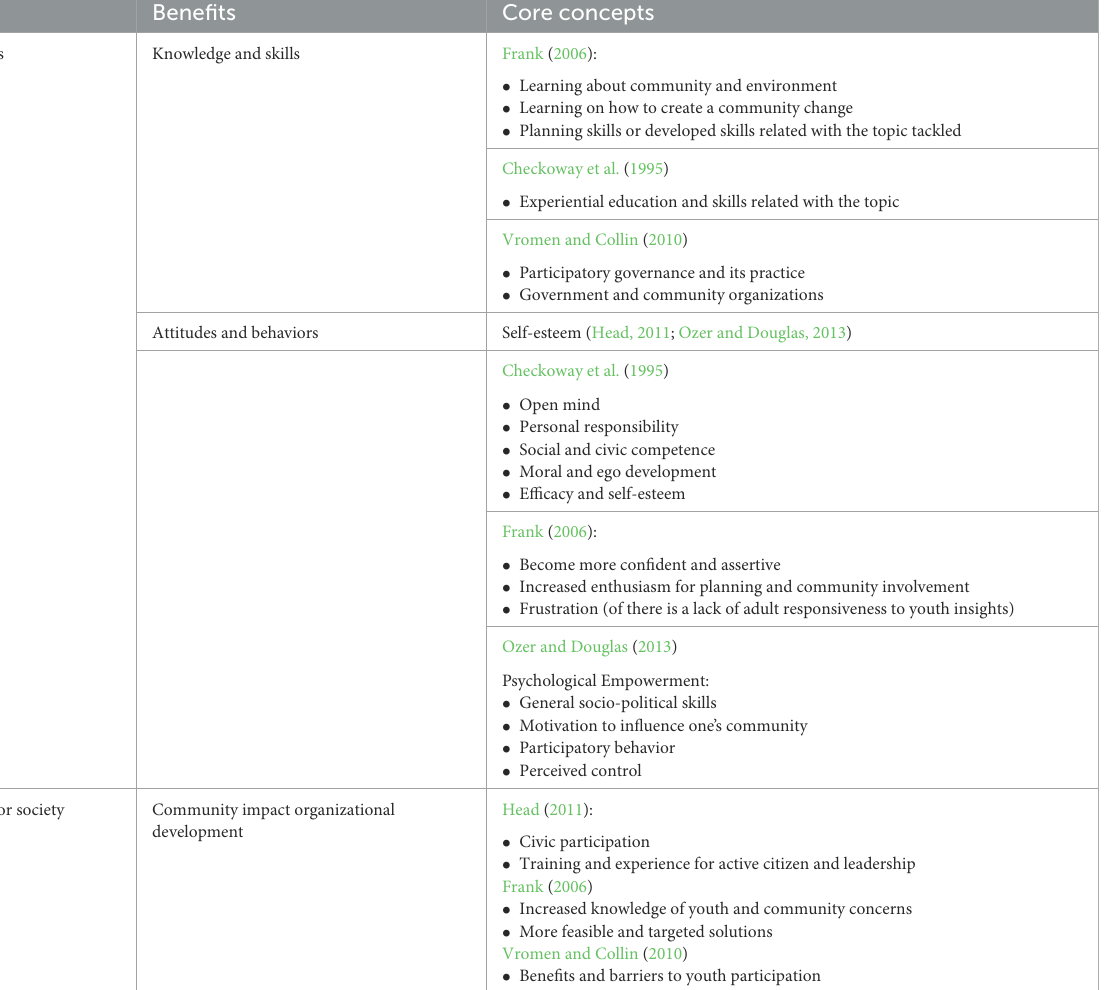
TABLE 1 Benefits of youth participation in policymaking at the individual and broader